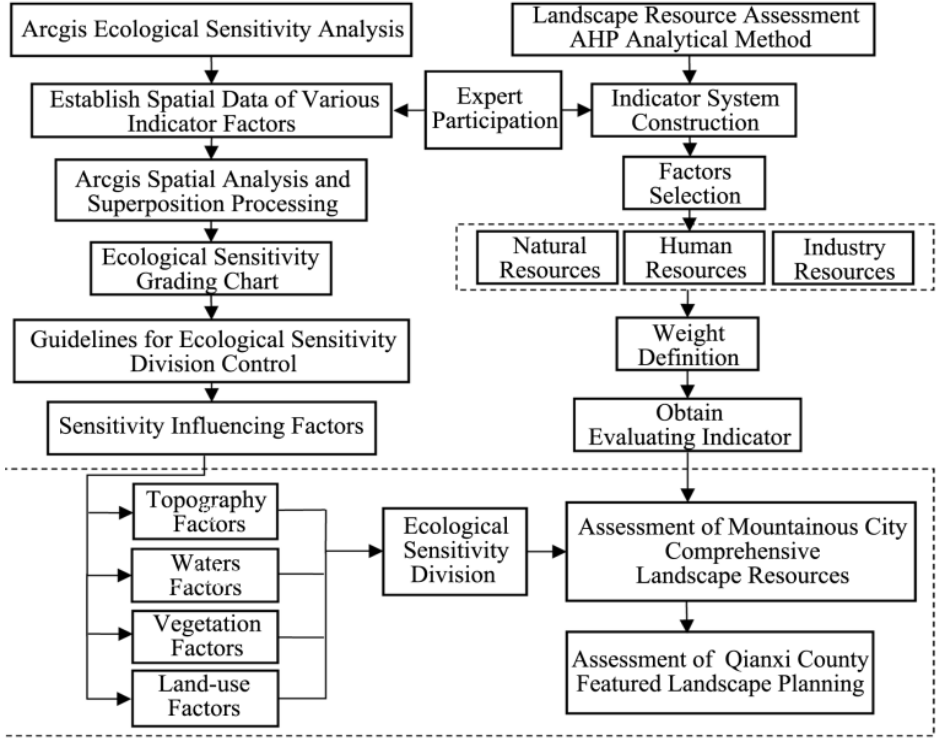
Figure 2. GIS-AHP analytical method-based featured landscape planning technical Figure 2. GIS ‐ AHP analytical method ‐ based featured landscape planning technical framework.